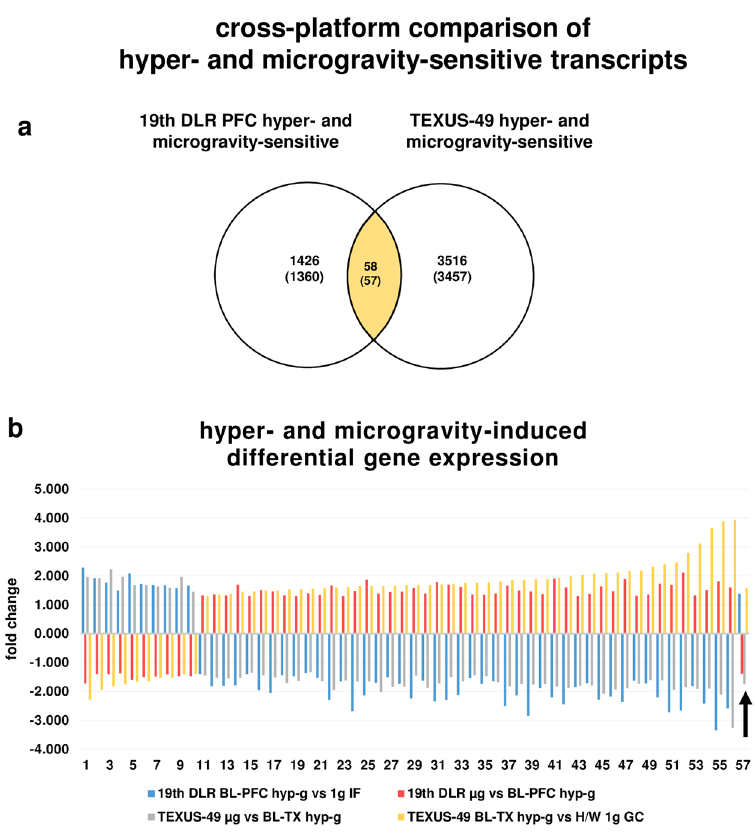
Figure 9. Hyper- and microgravity-double-sensitive transcripts identified for the 19 th DLR Parabolic Flight Campaign and the TEXUS-49 suborbital ballistic rocket campaign. ( a ) Venn diagram showing the intersection of hyper- and microgravity-double-sensitive transcripts of both platforms. ( b ) Graphical display of transcripts (annotated transcripts) showing that transcripts are regulated in the opposite direction between altered gravity conditions within one platform and between platforms. Only one transcript (arrow) was regulated in the same direction in both platforms. Fold changes (FCs) are ratios between the averages of linear expression values. If the ratio is < 1, FC is calculated as the negative reciprocal of the